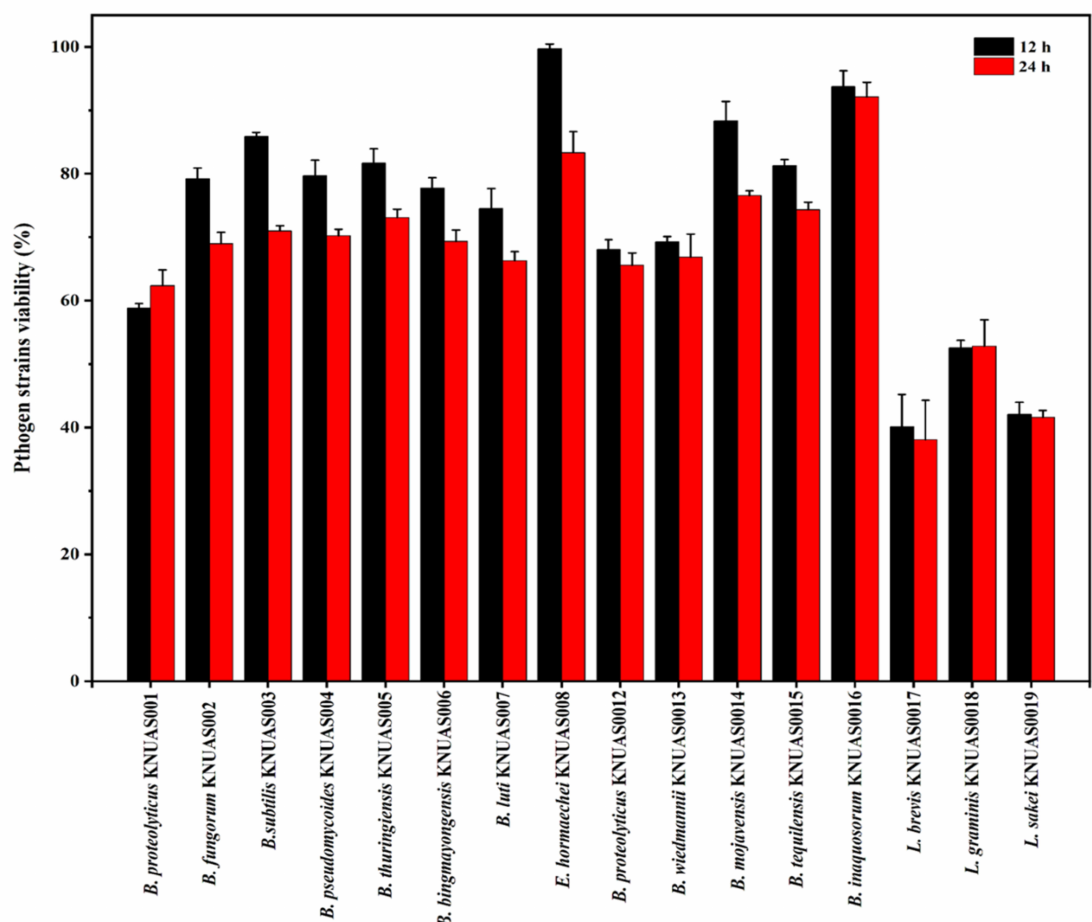
Figure 5. Antibacterial activity of cell free supernatant of isolated bacterial strains against Escherichia coli ( E. coli